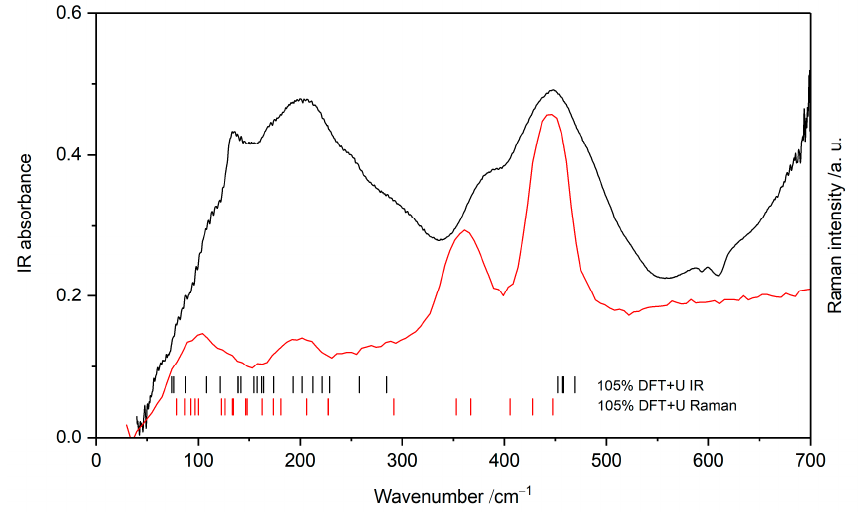
Figure 3. FIR (black) and Raman (red) spectra of KAgF 3 at room temperature together with marks indicating the computed wavenumbers.